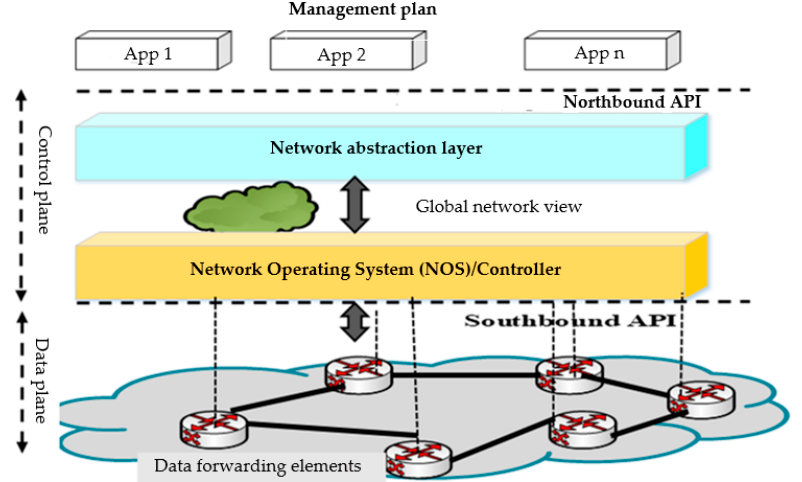
Figure 2. SDN 5G network architecture.